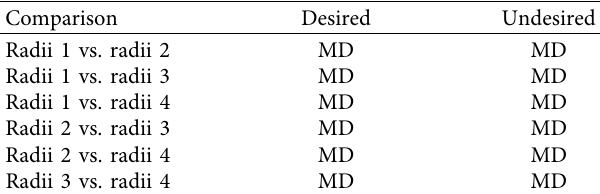
Table 22: Tukey–Kramer comparison test. MD means diferent. MnD means not diferent.